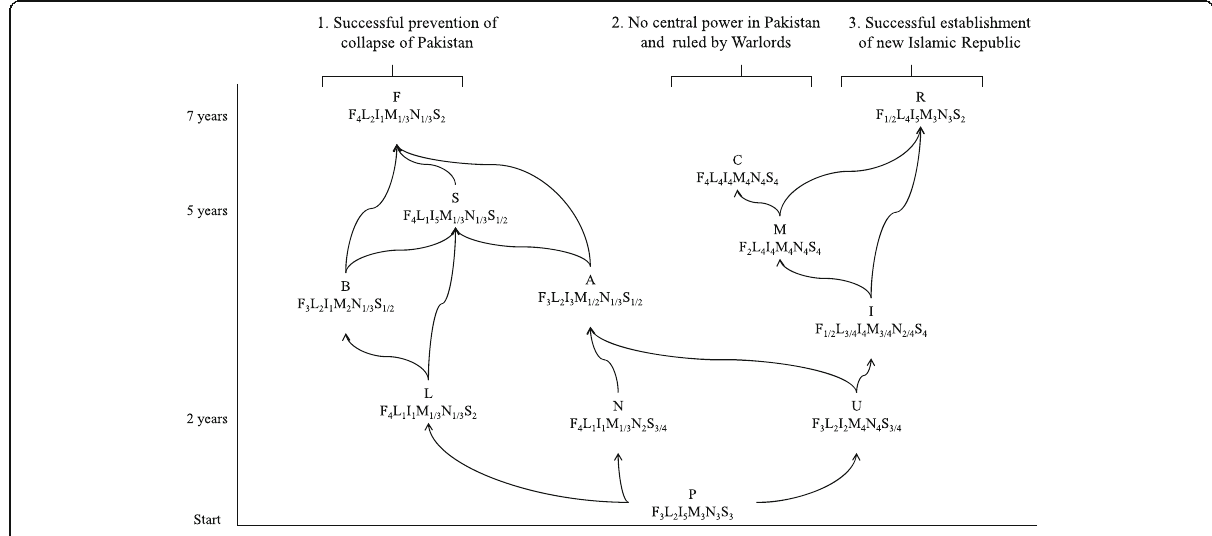
Fig. 1 The development of three scenarios using